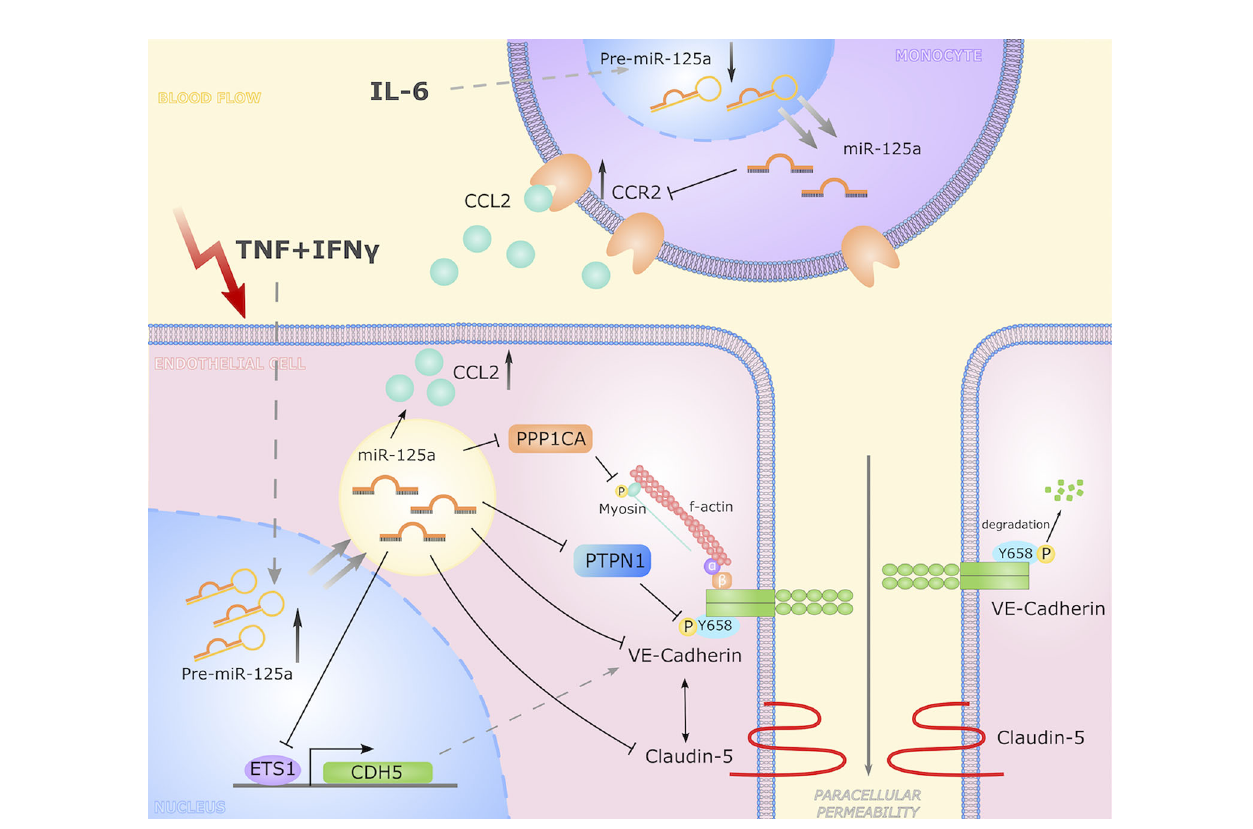
FIGURE 8 | Graphical representation of the miR-125a driven cell-crossing functional network. In response to in fl ammatory stimulation, the expression of miR-125a increases in endothelial cells. Here, miR-125a directly regulates CDH5, PTPN1, PPP1CA, and ETS-1 while CLDN5 levels are reciprocally linked to CDH5 expression. By reducing expression of ETS-1, miR-125a inhibits VE-Cadherin transcription. Via targeting PTPN1 and PPP1CA, miR-125a affects levels of phosphorylated VE- Cadherin, destabilizing adherens junctions and thus increasing paracellular permeability. In turn, monocytic expression of miR-125a is reduced upon in fl ammatory stimulation, leading to an induction of CCR2 expression, impacting monocyte